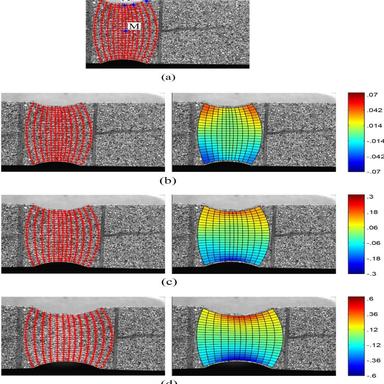
Sequence of frames acquired with one of the cameras, and its relative transversal displacement response to marker M (in mm), for the clip-gauge displacements of (a) 0 mm, (b) 1.36 mm, (c) 2.3 mm and (d) 3.58 mm.